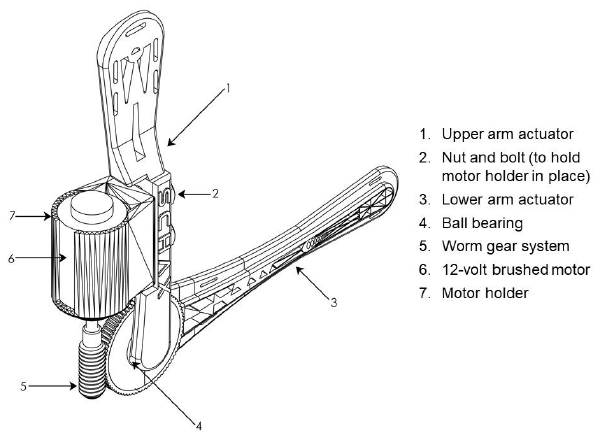
Figure 1: Computer-aided design of arm actuator assembly